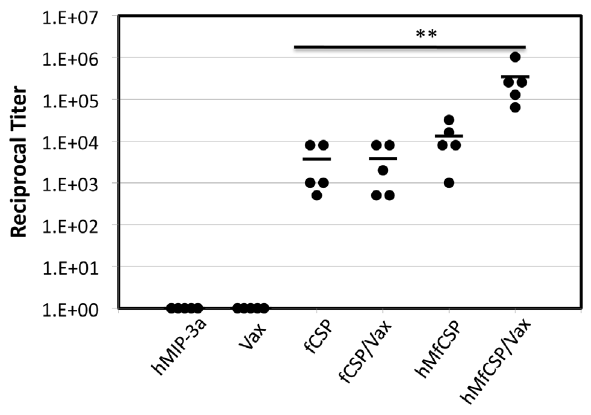
Figure 8. Antibody titers in mice immunized with the P. falciparum construct . C57BL/6 mice were immunized with 5 m g of the P. falciparum constructs of Figure 1 with or without Vaxfectin. Specific antibody concentrations. (Closed circles), which are reported as